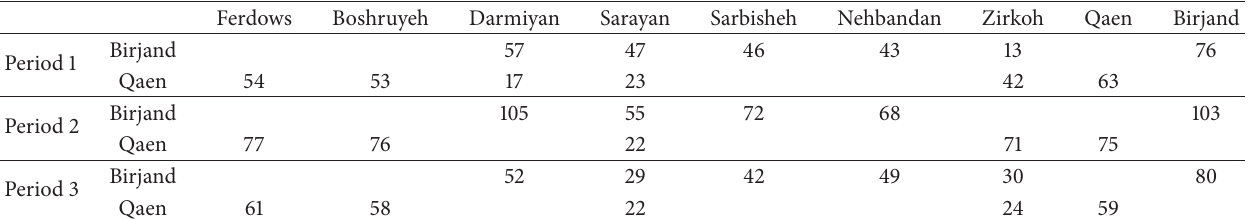
Table 13: Allocated commodity (type 2) ( ∗ 1000).